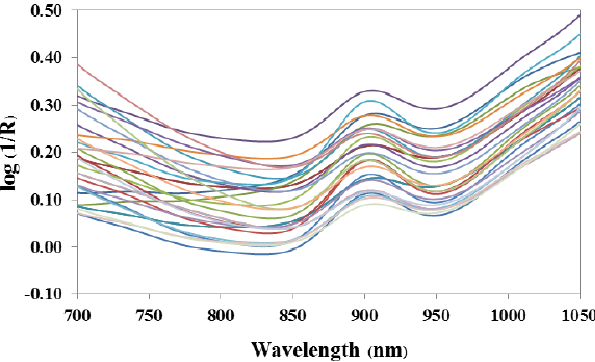
Fig. 2. Original spectra of raw rubber sheet in the short wavelength